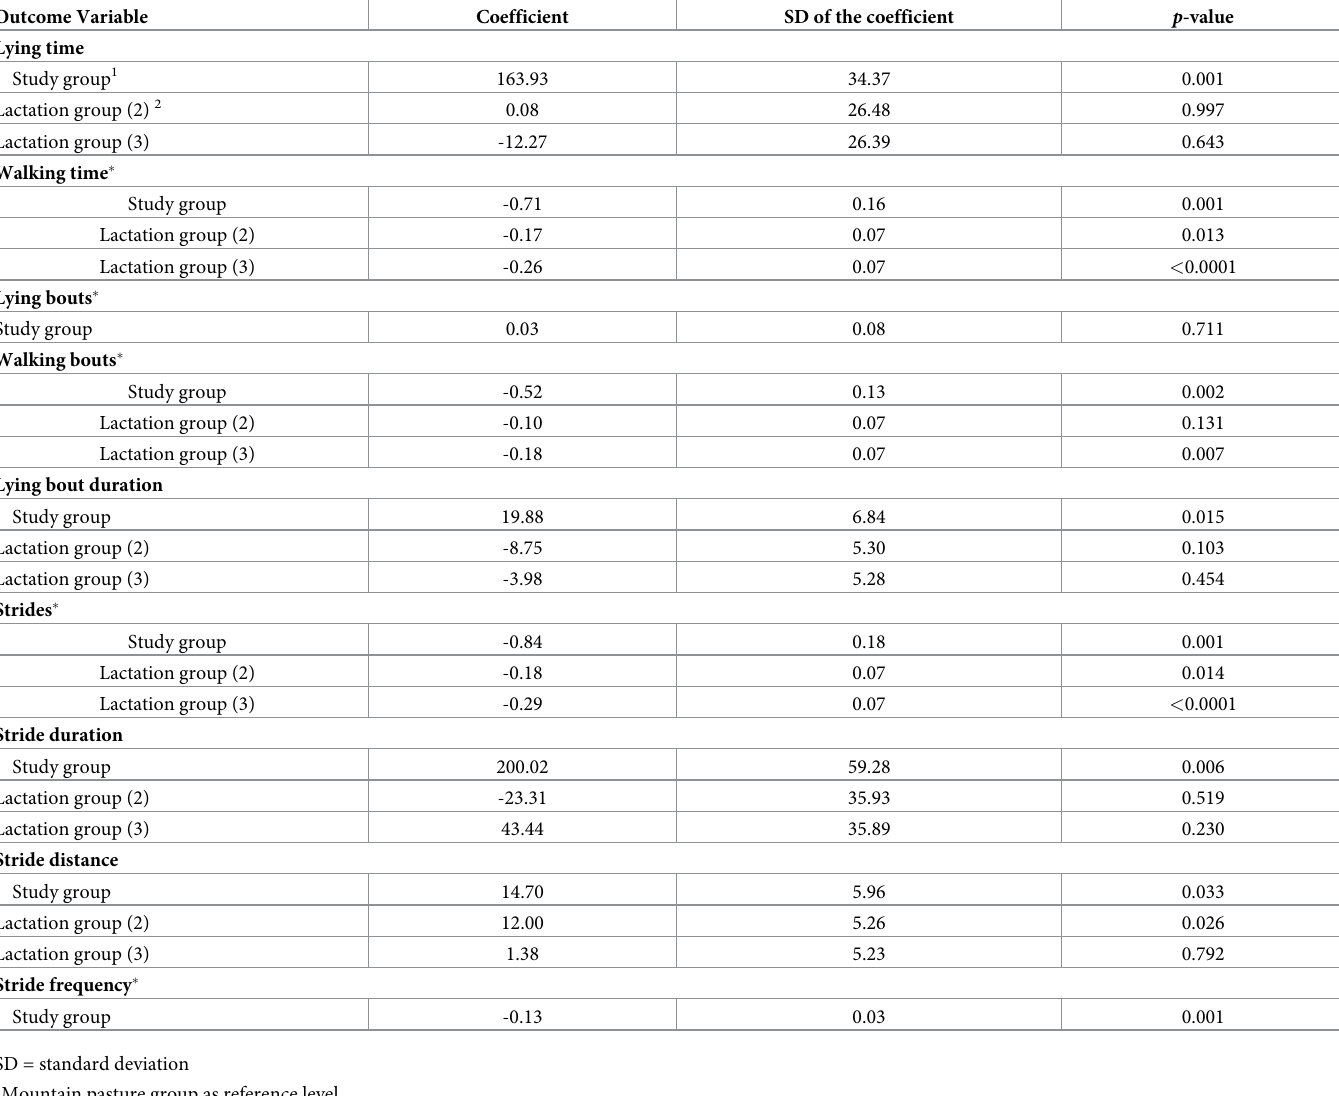
Using multivariable linear mixed effect models considering DIM and lactation group in addition to the study group (mountain versus cubicle housing system), number of strides, walking time, walking bouts and stride distance were found to be significantly related to the lactation group (Table 3). Table 3. Coefficient of the variables study group, days in milk and lactation group on the outcome of accelerometer variables during 24-hour locomotion activity budget using multivariable linear mixed effect regression model. Outcome Variable Coefficient SD of the coefficient p -value 163.93 34.37 0.001 0.08 26.48 0.997